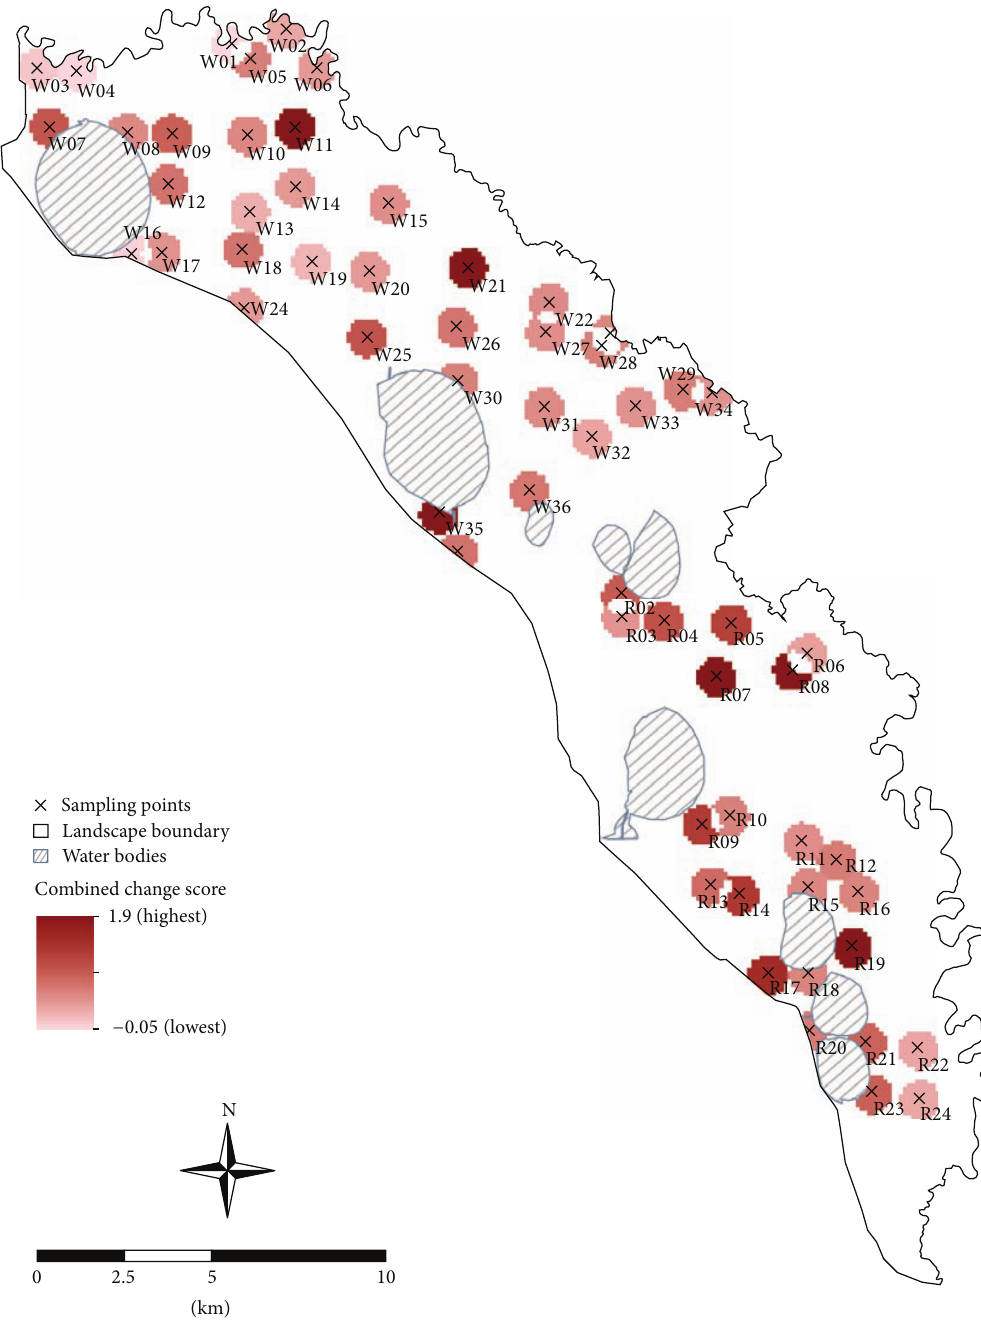
Figure4:“Hotspot”mapindicatingcombinedrelativechangeinthetwoserviceindicators(soilorganiccarboncontentandsoilwaterstorage) from current (time = 0) to future (time = 25 years) land-use scenarios at each of 60 sampling points. Potential combined scores range from − 2 (maximum negative change in both indicators) to +2 (maximum positive change in both